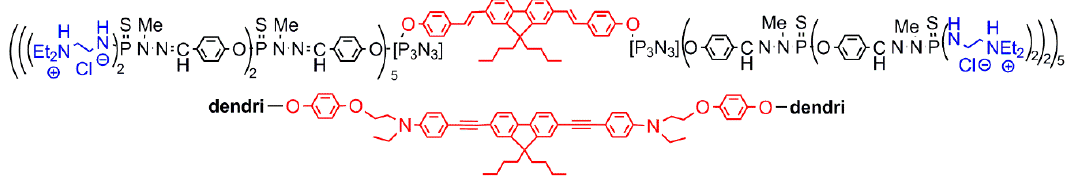
Figure 4. Two dendrimers with a TPA fluorophore as core have been used for imaging the vascular network of a rat olfactory bulb ( top ), and the blood vessels of a tadpole ( bottom ).